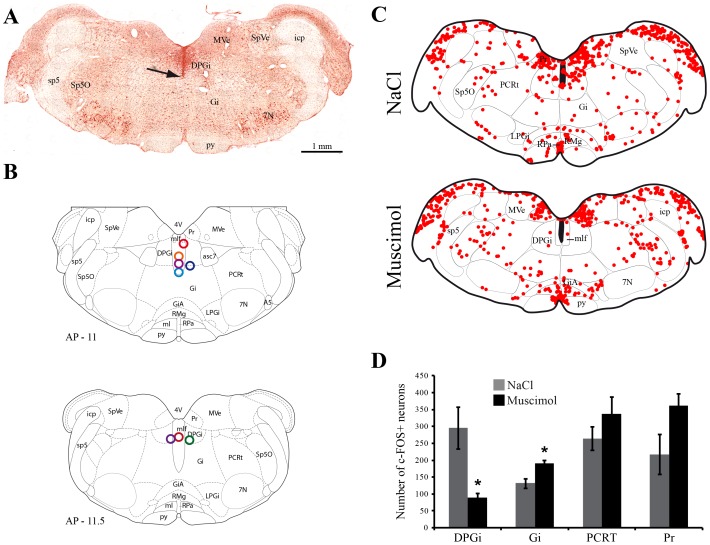
Muscimol injection into the DPGi reduces c-FOS expression specifically within the DPGi.For each animal, the injection site was localized at the end of the protocol. A, Example of a DPGi injection site on a neutral red counterstained section. The tip of the cannula is indicated by a black arrow. B, Drawing showing the localization of all injection sites. Adapted from Paxinos and Watson Rat Brain atlas, 5th edition. The antero-posterior localization of each drawing is indicated at the left bottom corner in mm from the bregma. C, Drawings showing the distribution of c-FOS positive neurons (red dots) on a section at the level of the injection site in two representative animals perfused 3 h after NaCl ormuscimol injection in the DPGi. The black filled area represents the cannula trace. D, Number of c-FOS+ neurons counted in the DPGi and in the surrounding regions after muscimol and NaCl injection in the DPGi. Values are mean ± SEM, n = 4 in each group, *p<0.05 between muscimol and NaCl. Abbreviations: 7N, facial nerve; 4V, 4th ventricle; DPGi, dorsal paragigantocellular reticular nucleus; Gi, gigantocellular reticular nucleus; GiA, gigantocellular reticular nucleus, alpha part; icp, inferior cerebellar peduncle; LPGi, lateral paragigantocellular reticular nucleus; mlf, medial longitudianl fasciculus; MVe, medial vestibular nucleus; PCRt, parvicellular reticular nucleus; Pr, prepositus nucleus; py, pyramidal tract; RMg, raphe magnus nucleus; RPa, raphe pallidus nucleus; sp5, spinal trigeminal tract; Sp5O, spinal trigeminal nucleus, oral part; SpVe, spinal vestibular nucleus.